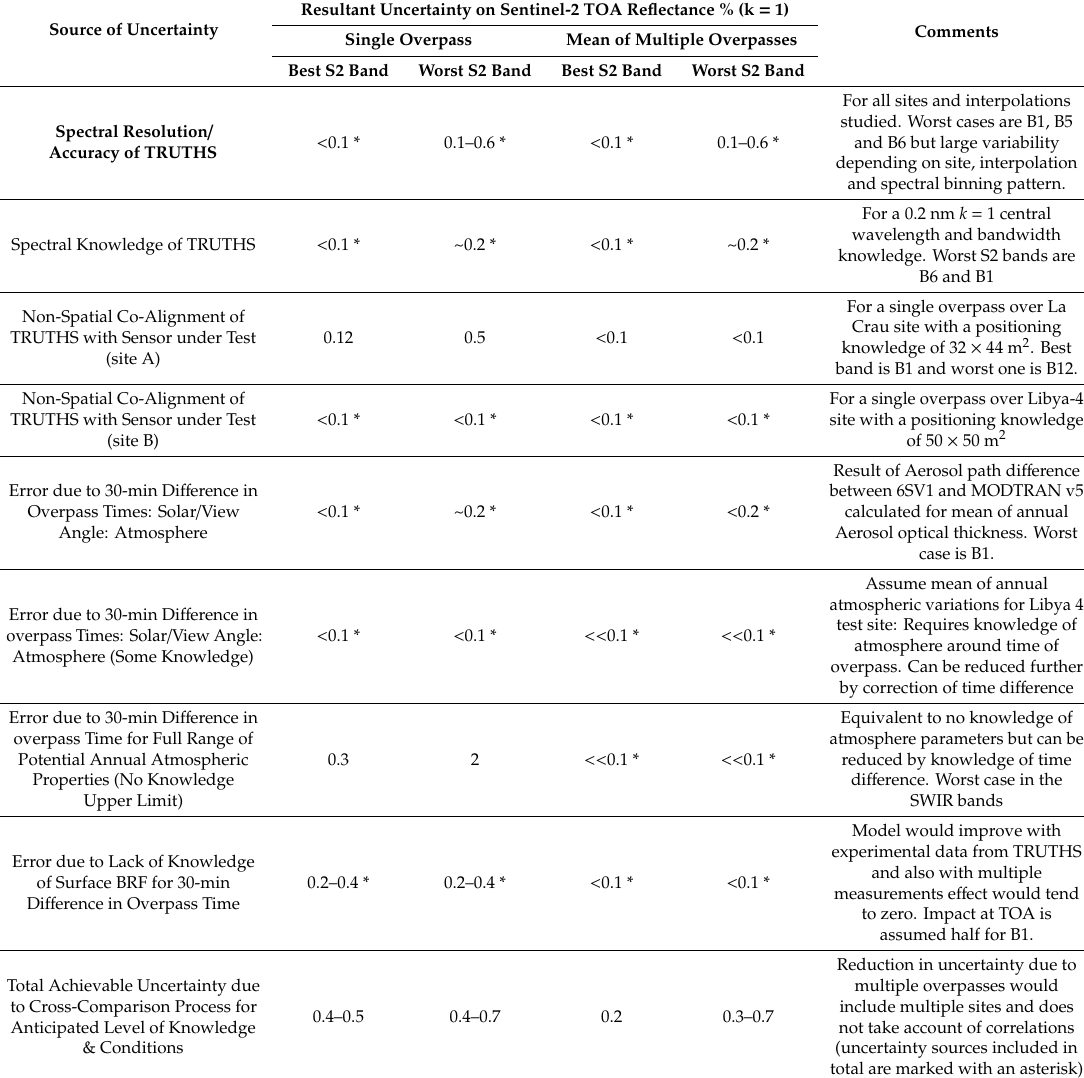
Table 6. Uncertainty budget (k = 1) achievable for the upgrade of the radiometric performance of Sentinel 2 using TRUTHS as a reference sensor and the Libya-4 PICS. The contributions marked with an asterisk are included in the total at the bottom of the table. Some contributions are calculated based on a potential range of conditions and only one variant is used in the